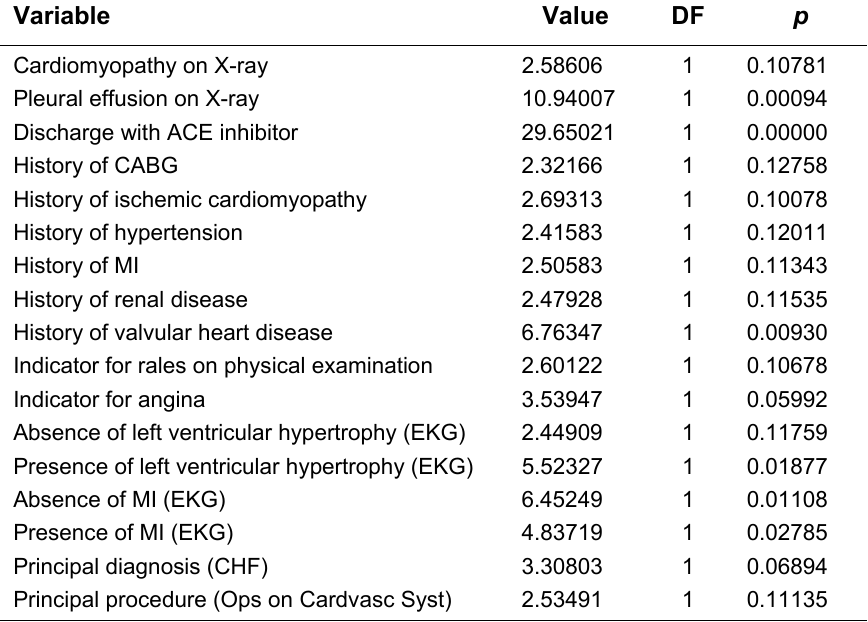
Mortality within 90/365 Days of Discharge — Pearson Chi-Square 90 Days